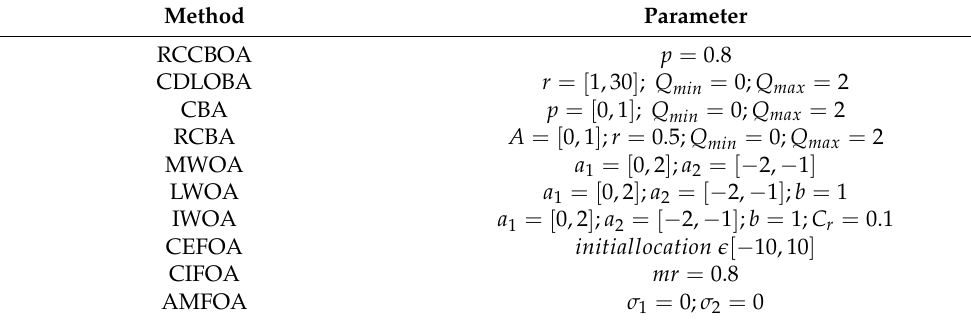
Table 5. Parameters setting of the RCCBOA and other